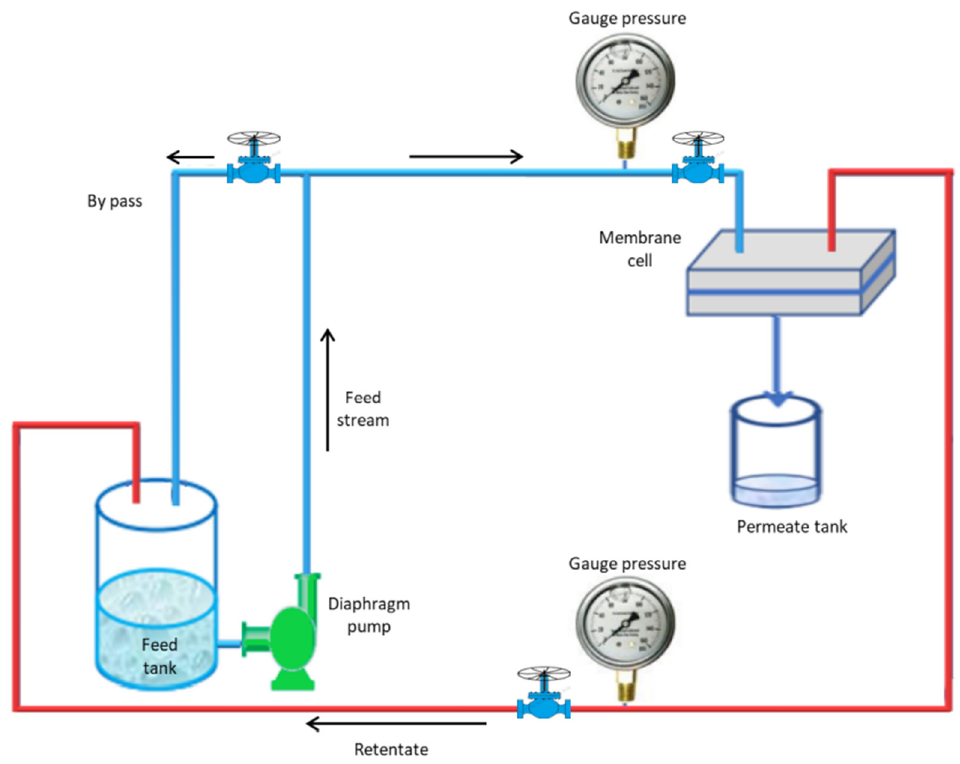
Figure 3. Schematic diagram of the experimental nanofiltration system. Equations (1) and (2) [56] were used to calculate the permeate flow and rejection % of all membranes.